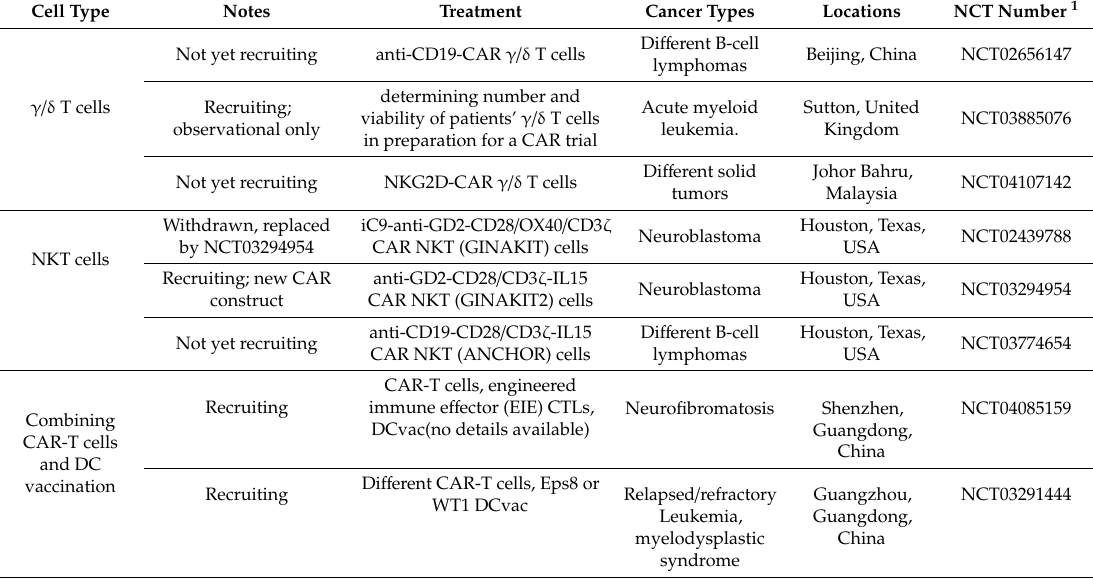
Table 1. List of clinical trials employing non-classical / alternative chimeric antigen receptor (CAR) vehicles or combinations listed on